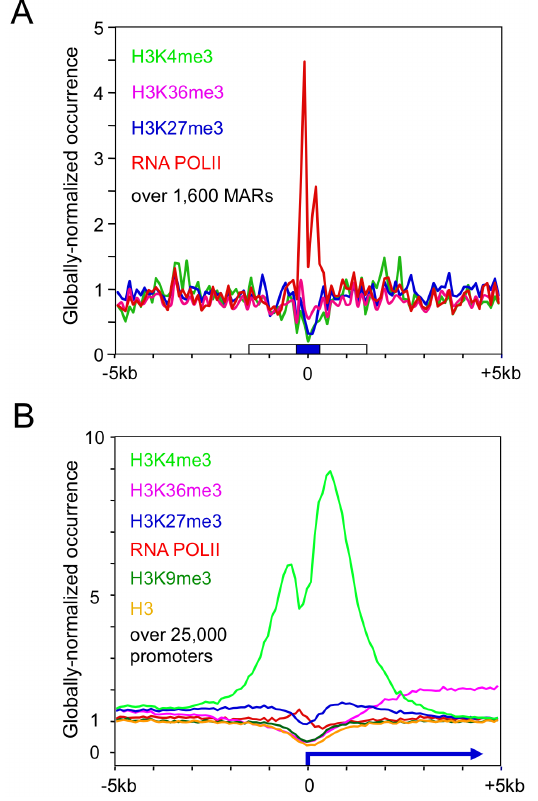
Figure 5. Association of human MARs with a specific chromatin pattern. A) 1683 predicted human MAR genomic locations were aligned using the central positions of their AT rich cores. ChiP-Seq profiles were calculated over the MAR collection for the histone modifications H3K4me3, H3K27me3, H3K36me3 and for RNA Polymer- ase II. (B) 25000 RefSeq promoters were aligned at their respective TSS positions and oriented according to the direction of transcription. ChiP- Seq profiles were calculated over the promoter collection for indicated histone modification, and for the RNA Pol II. Tag counts were normalized globally and they are expressed as a fold change over the non-precipitated input DNA profile.